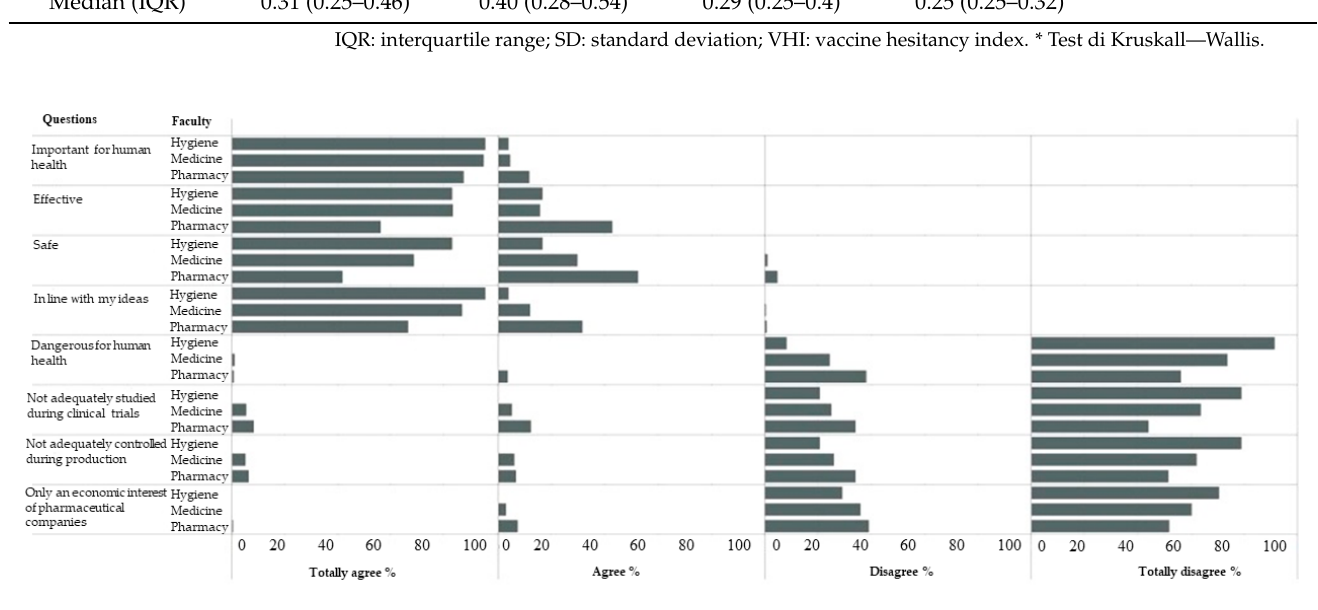
Figure 1. The percentage of students who agreed or disagreed with the eight Likert-type statements. Table 3. Vaccine Hesitancy Index.